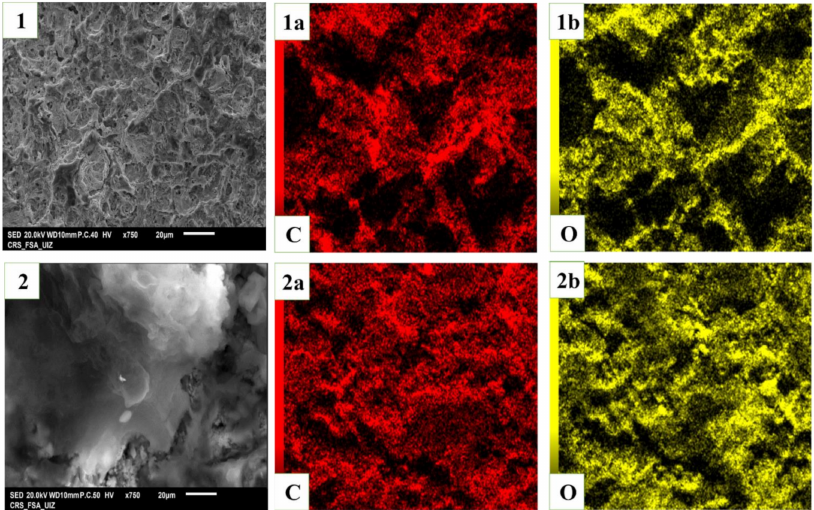
Figure 13. Elemental mapping images of Ti/Pt/SnO 2 electrode by SEM: ( 1 ) before electrolysis, ( 2 ) after electrolysis, (C: Carbon, O: